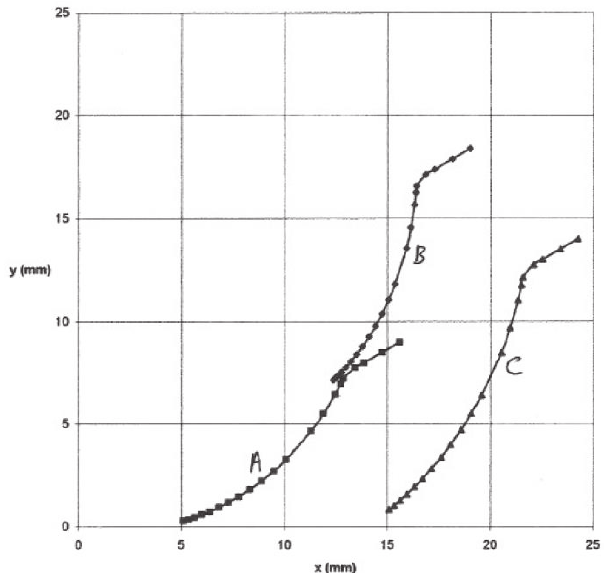
Figure 8A: Showing the trajectories of the transfusion set for the TN- point (curve A), the paths of the G-points with l g = 10 mm, β = 40 ◦ (curve B) and l g = 10 mm, β = 0 ◦ (curve C). All other parameters same as for Figure 6A.